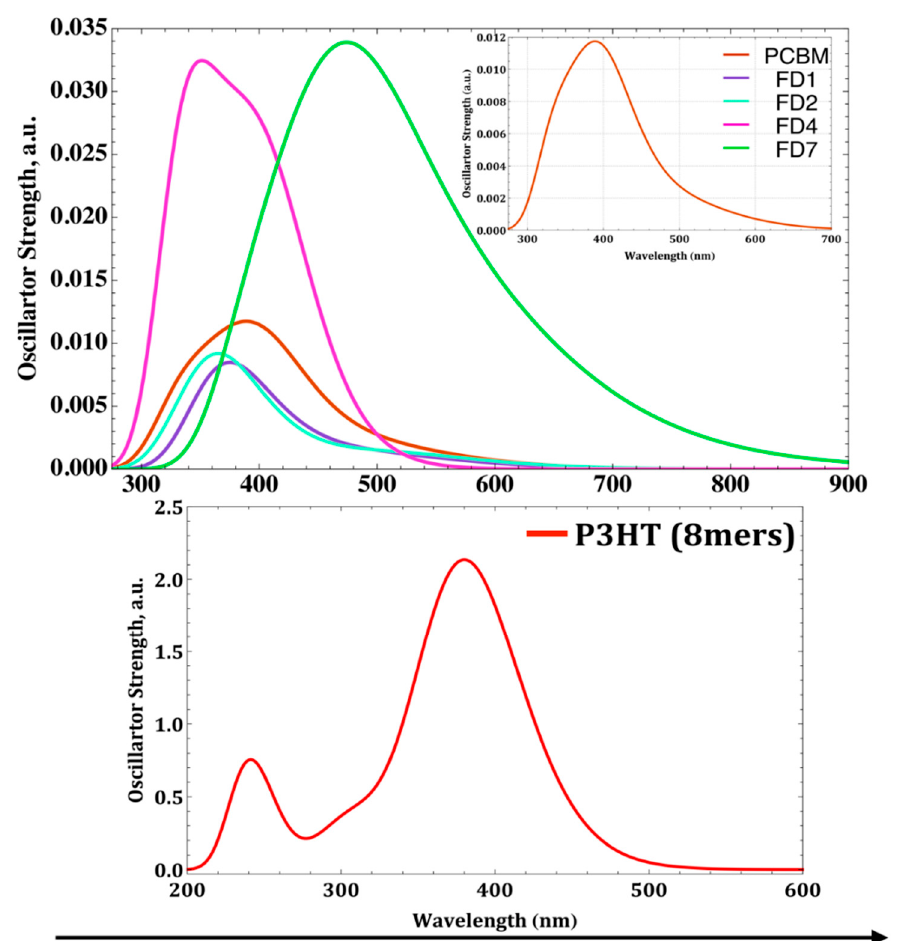
Figure 6. Simulated absorption spectra of PCBM, four FDs [Top] and P3HT [Bottom] with the use of TD/CAM-B3LYP/6-311G(d,p) level of theory in chlorobenzene solvent. Inset Top: Magnified PCBM absorption spectrum.